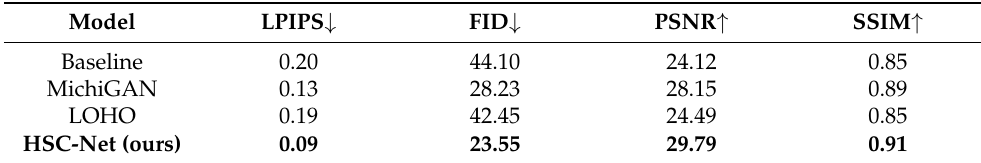
Table 2. Our method performed the best in all metrics, including LPIPS, FID, PSNR, and